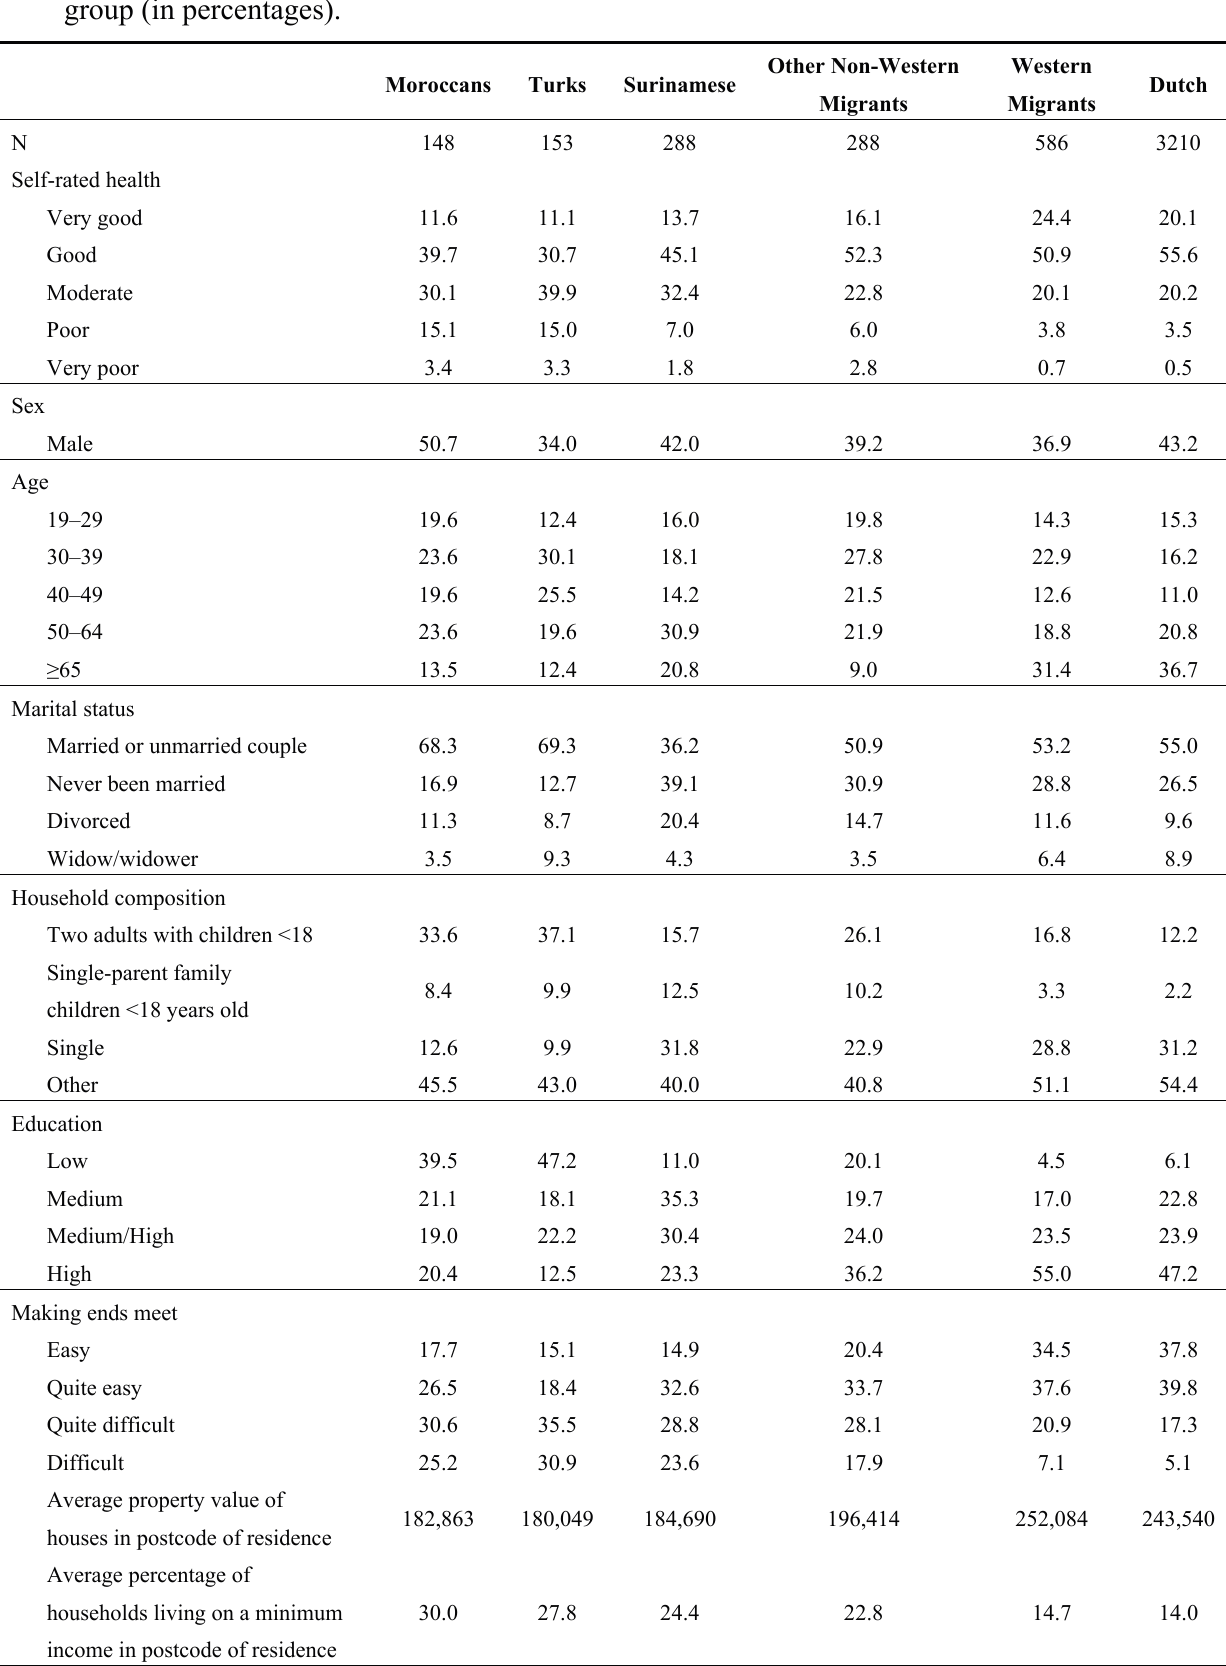
Other Non-Western Western Dutch Migrants Migrants